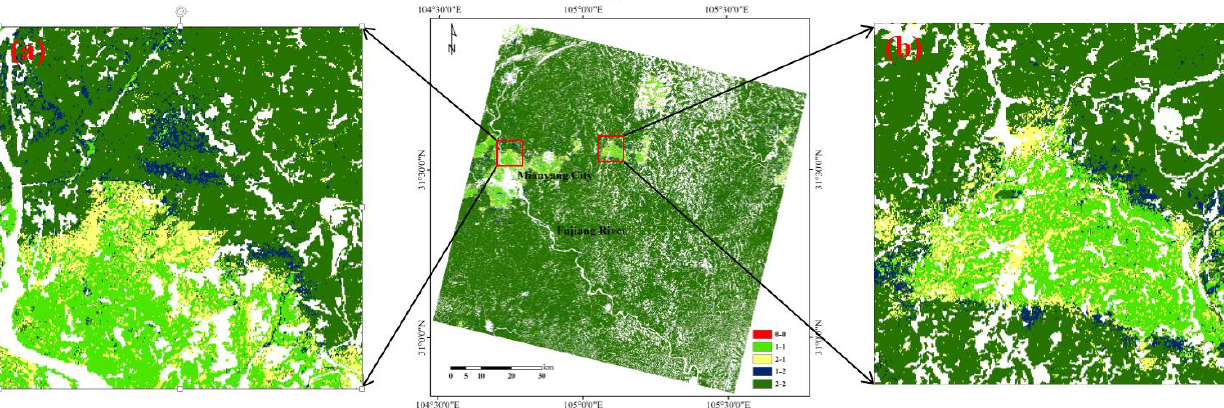
Figure 8. Comparison map between the results of cropping intensity based on two HTSNs synthesized by two different schemes. The former of the “x-x” in the map legend indicates the result of Scheme 1, and the latter indicates the result of Scheme 2. For example, 2-1 indicates that the result for Scheme 1 is 2, while that for Scheme 2 is